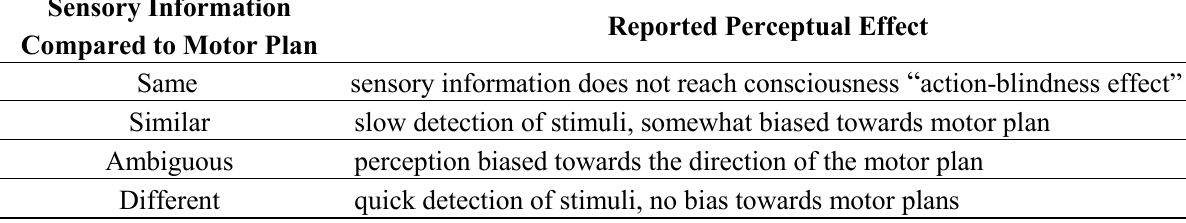
Table 1. Relationship between sensory information and concurrent motor plans and their consequent perceptual